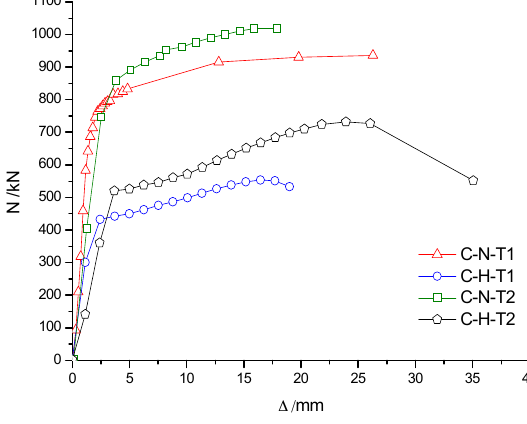
Figure 12. Influence of wall-thickness on N- Δ curves.